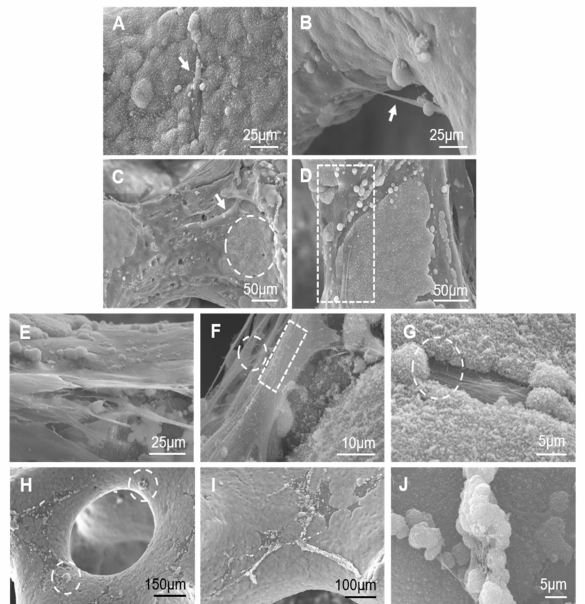
Figure 5. SEM micrographs at different magnifications of scaffold surfaces seeded with ah-MSCs in GM for: ( A , B ) 7, ( C – G ) 14 and ( H – J ) 28